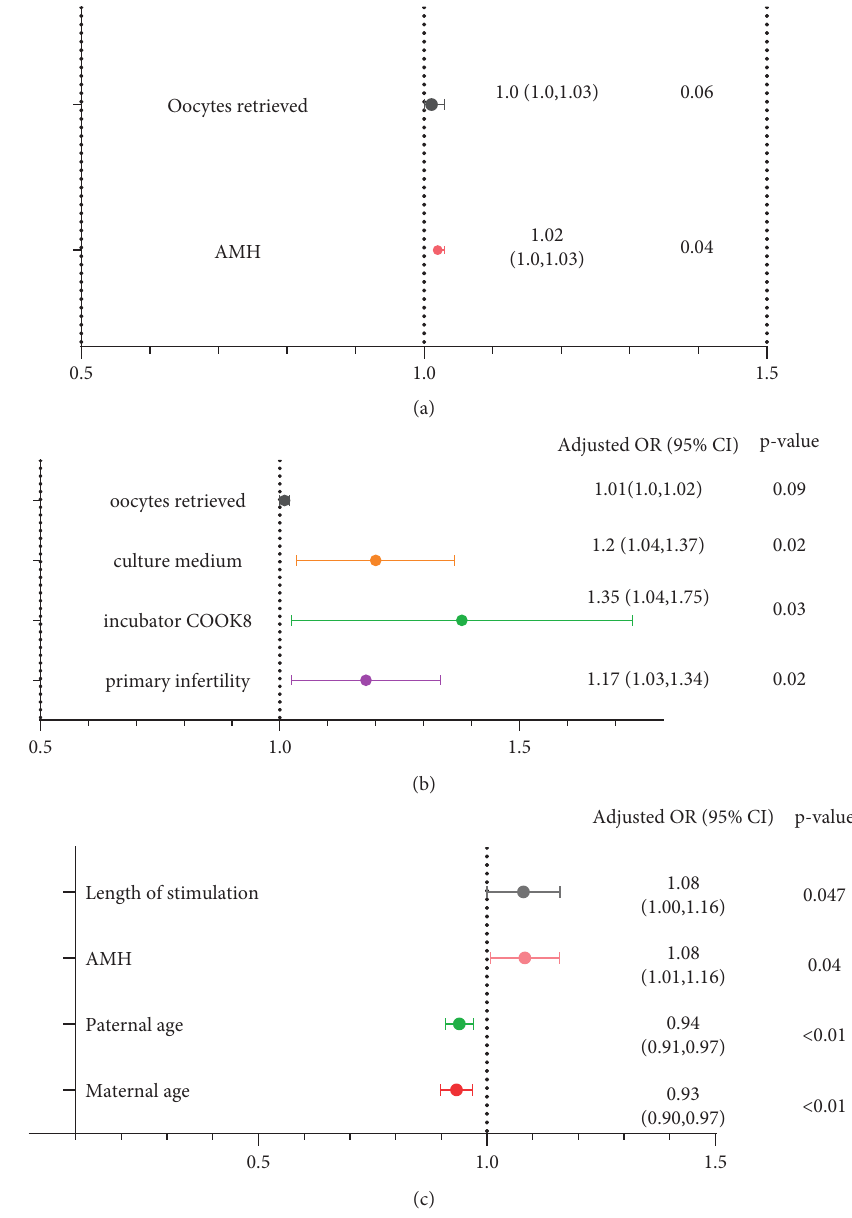
Figure 2: Univariate logistic regression analysis of cleaving speed, quality, and clinical results of day-3 embryos. (a) Variables associated with 7–10 cell embryos; (b) variables associated with MGE; (c) variables associated with successful implantation. AMH: anti-Mullerian hormone; MGE: morphological good